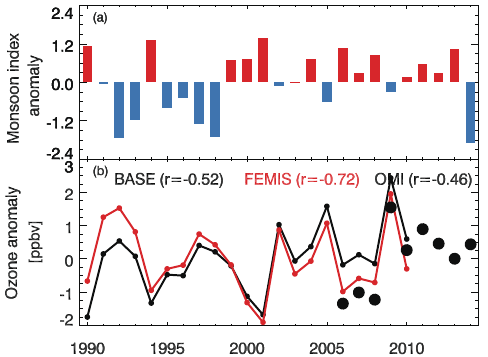
Figure 7. Time series of (a) South Asian summer monsoon index and (b) lower tropospheric ozone averaged over India in summer monsoon seasons. Values are anomalies over 1990–2010. OMI ob- served ozone anomalies are shown by black circles, and model re- sults from the BASE and the FEMIS simulation are shown by black and red lines, respectively. Interannual correlation coefficients with the monsoon index are shown